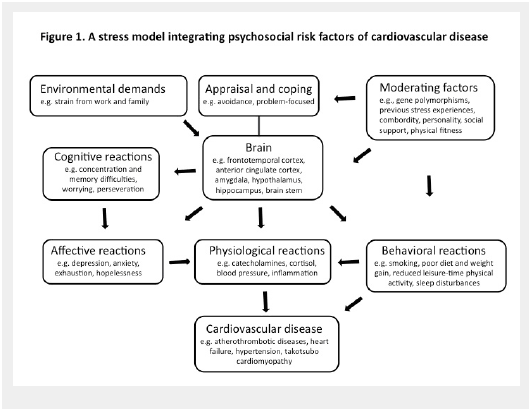
Depending on appraisal, coping resources, and several moderating factors, environmental demands trigger a neurobiologically driven stress reaction across cognitive, affective, behavioural, and physiological domains, all contributing directly and/or indirectly to cardiovascular